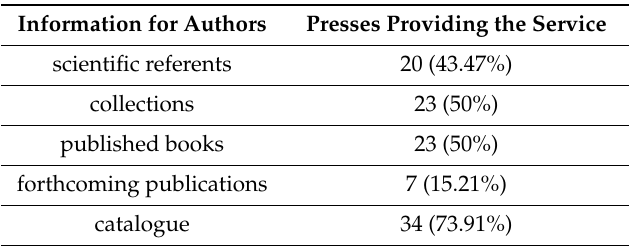
Table 3. Instructions for authors, published on the press website.